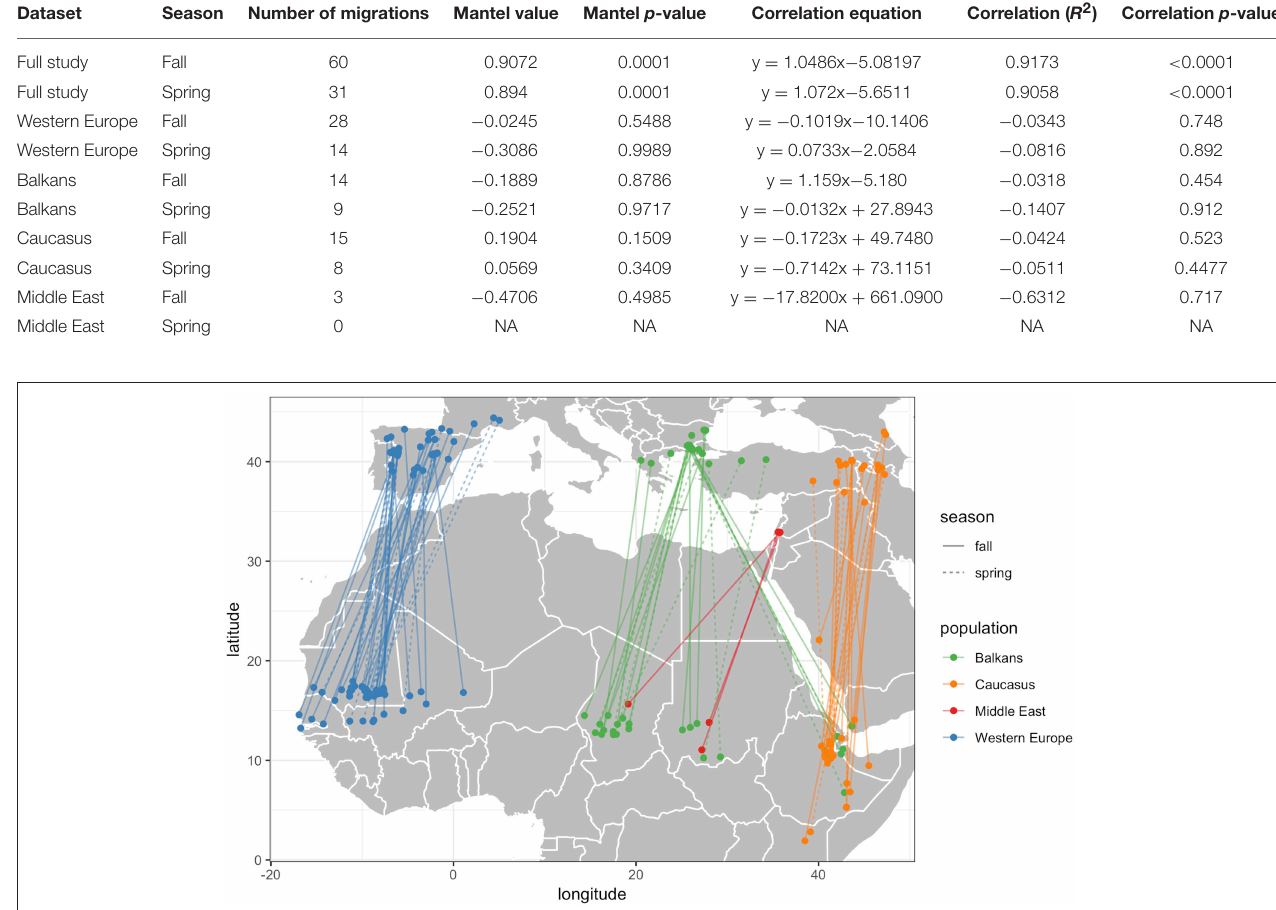
TABLE 2 | Mantel correlation coefficients of migratory connectivity and R-squared correlation coefficients between longitudes of migration start and end locations from the first completed migration of each individual in each season. Dataset